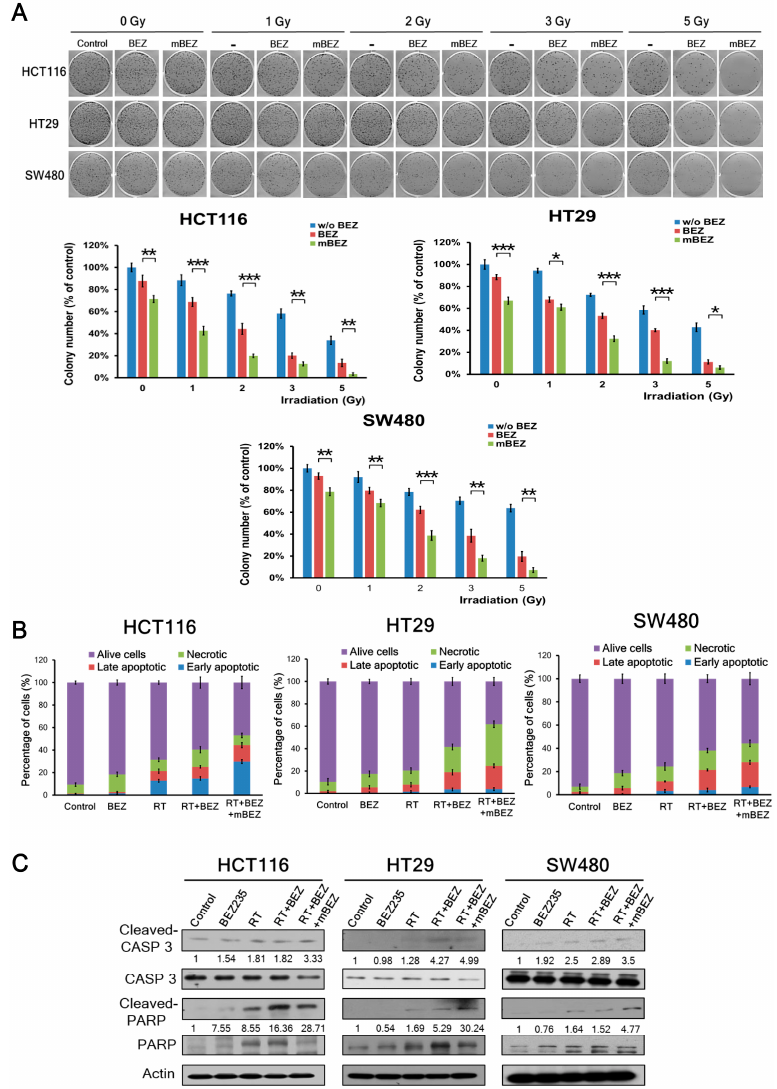
Figure 2. BEZ235 maintenance treatment following RT + BEZ235 treatment resulted in significantly less cell survival and more apoptosis markers in CRC cells. ( A ) In three CRC cell lines (HCT116, HT29, and SW480), a colony formation study (1000 cells per well) showed that the rate of cell survival significantly decreased after RT + BEZ235 + mBEZ235 treatment. In addition, RT + BEZ235 + mBEZ235 treatment exhibited a RT dose-dependent reduction in clonogenic survival fraction. The results are expressed as the mean ± standard error (SE) of three experiments. * p < 0.05; ** p < 0.01; *** p < 0.001. ( B ) Quantification of apoptosis via annexin V-propidium iodide staining of the HCT116, HT29, and SW480 cells after various treatments. Completely apoptotic cells were more prominently found after RT + BEZ235 + mBEZ235 treatment. ( C ) Western blotting showed that BEZ235 maintenance treatment substantially enhanced the level of apoptosis (cleaved caspase-3 [CASP 3] and cleaved PARP) induced by radiation. PARP, CASP 3, and β -actin served as the controls. The band intensities were analyzed by ImageJ software. The relative ratios of the cleaved protein to non-cleaved protein amounts were quantified and indicated underneath each gel. The relative ratio of the control group is arbitrarily presented as 1.